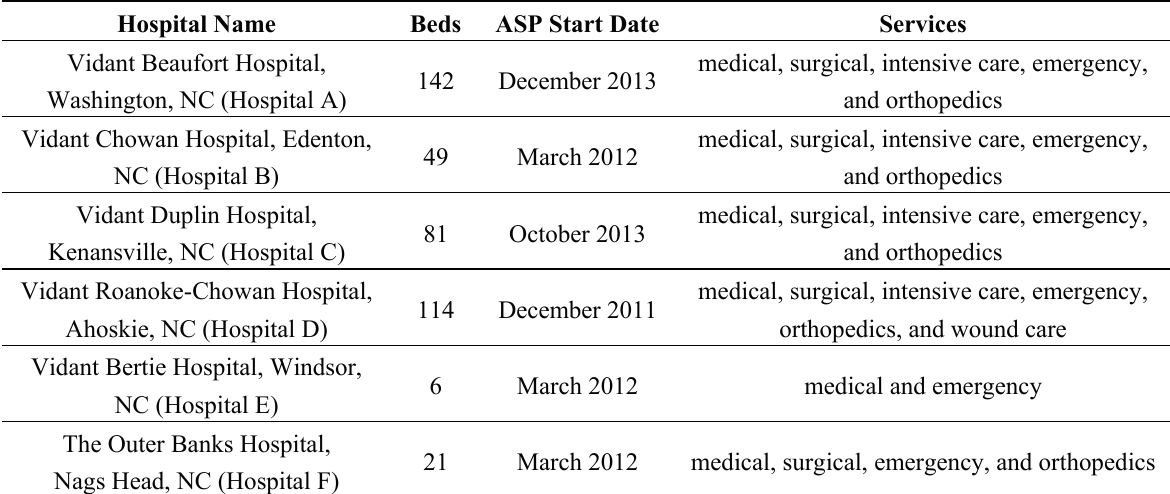
Table 1. Characteristics of Vidant community